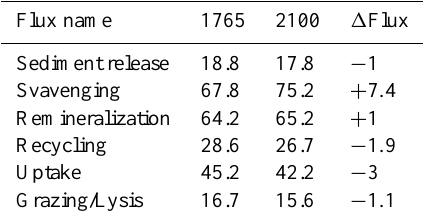
Table 3. Simulated fluxes in the iron cycle expressed in Gmol Fe yr − 1 for the preindustrial model state at year 1765 and a future state at year 2100. The difference of the fluxes is denoted by (cid:49)